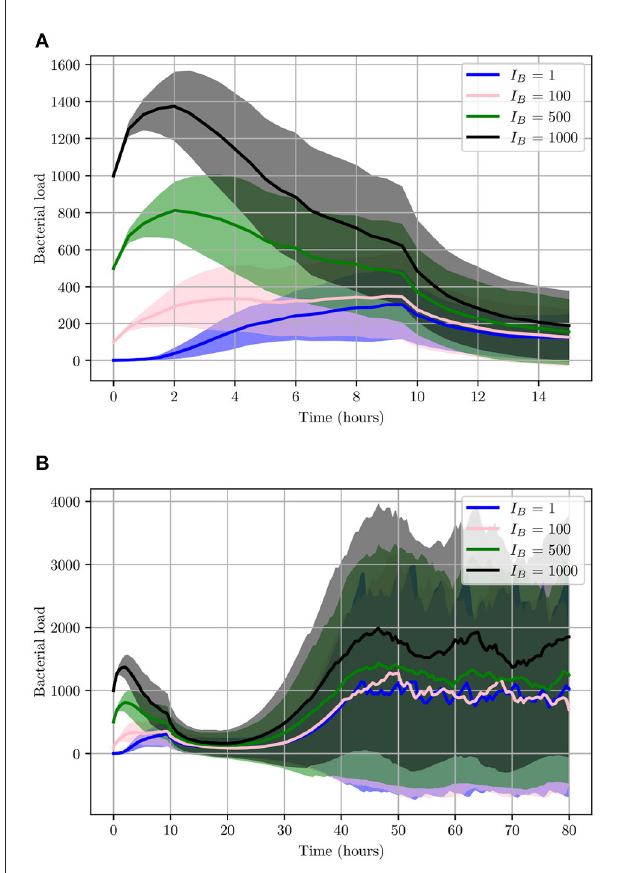
FIGURE11 Average values for bacterial load. (A) The early stage with initial bacterial loads I B ∈ { 1,100,500,1,000 } . (B) The average loads throughout the entire simulation (0 < t < 80). Ninety-five percent confidence intervals are shown by the shaded